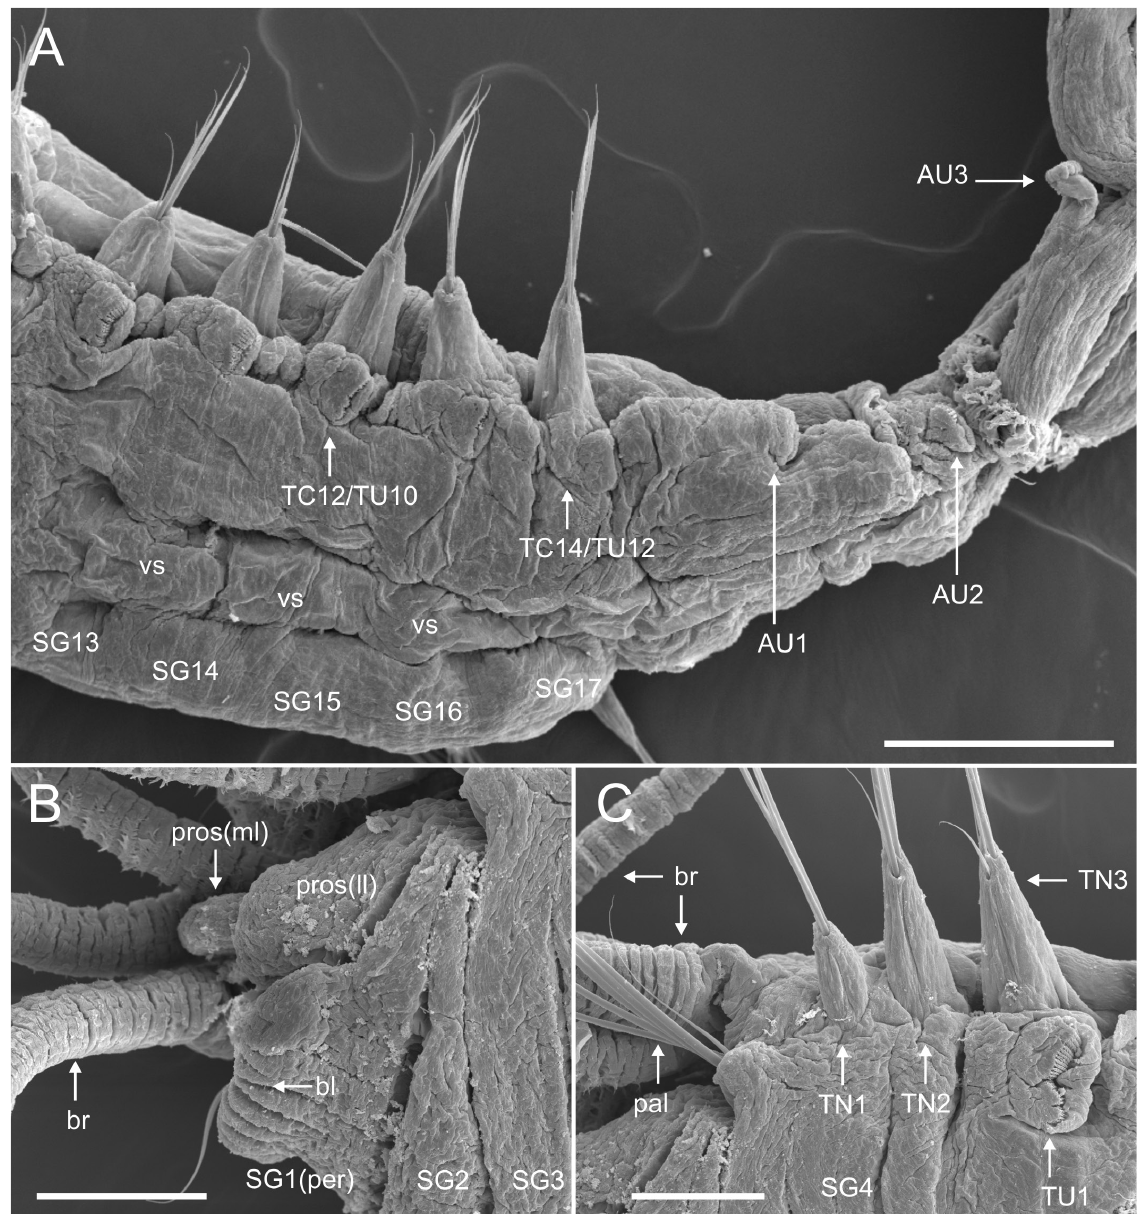
Fig. 5. Ampharete oculicirrata sp. nov., paratype MNCN 16.01/18482_spec. 3. A . Transitional area between thorax and abdomen, ventral view. B . Peristomium, ventral view. C . Paleae and first three thoracic chaetigers, ventral view. Abbreviations: AU = abdominal unciniger; bl = buccal lip; br = branchia; pal = paleae; per = peristomium; pros(ll) = prostomium (lateral lobe); pros(ml) = prostomium (median lobe); SG = segment; TC = thoracic chaetiger; TN = thoracic notopodium; TU = thoracic unciniger; vs = ventral shield. Scale bars: A = 200 µm; B–C = 100